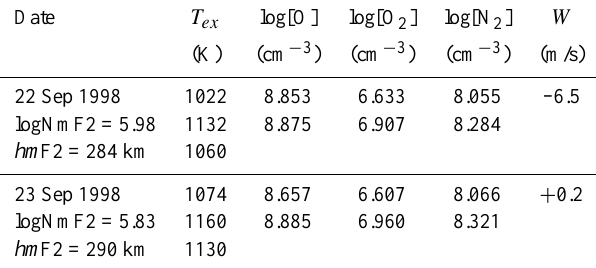
Table 6. Calculated thermospheric parameters at Millstone Hill compared with MSIS-83 model predictions (second line) at 300 km.